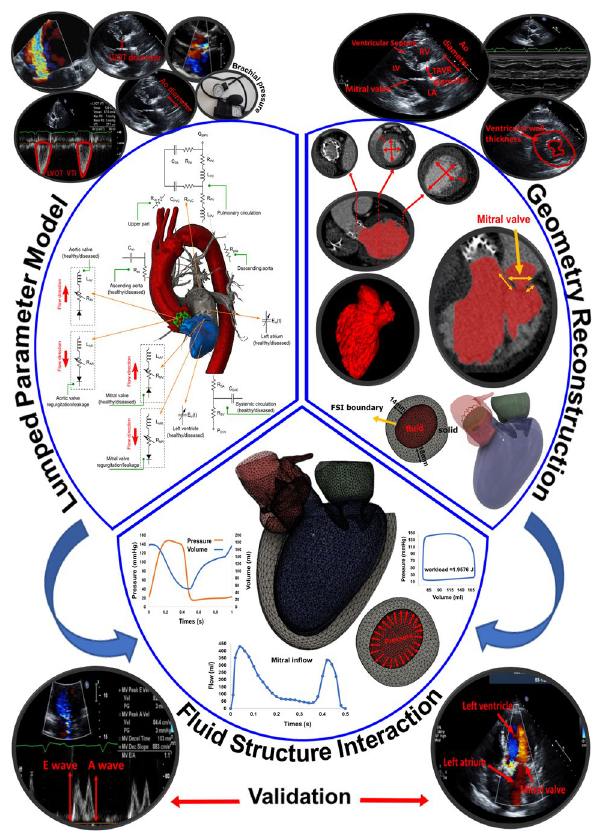
Figure 1. Schematic diagram of computational domain . Anatomical and electrical schematic diagrams of the lumped parameter modeling. This model includes the following sub-models. (1) left atrium, (2) left ventricle, (3) aortic valve, (4) mitral valve, (5) systemic circulation, and 6) pulmonary circulation. Abbreviations are the same as in Table 1. Input parameters were measured using Doppler echocardiography and sphygmomanometer. Simulation domain and FSI modeling. Imposing correct boundary conditions to the flow model is critical because the local flow dynamics are influenced by downstream and upstream conditions. Patient-specific LPM simulating the function of the left side of the heart was coupled to the inlet of the mitral valve model. This data was obtained from the patient-specific image-based lumped parameter model. Input parameters to the lumped parameter algorithm were reliable measured using OsiriX imaging software (OsiriX version 8.0.2; Pixmeo, Switzerland). We used ITK-SNAP (version 3.8.0-BETA) to segment and reconstruct the 3-D geometries of the complete ventricle using CT images. Geometries were used for investigating hemodynamics using FSI and LPM. Mesh for all models was generated using SALOME (an open-source mesh generation